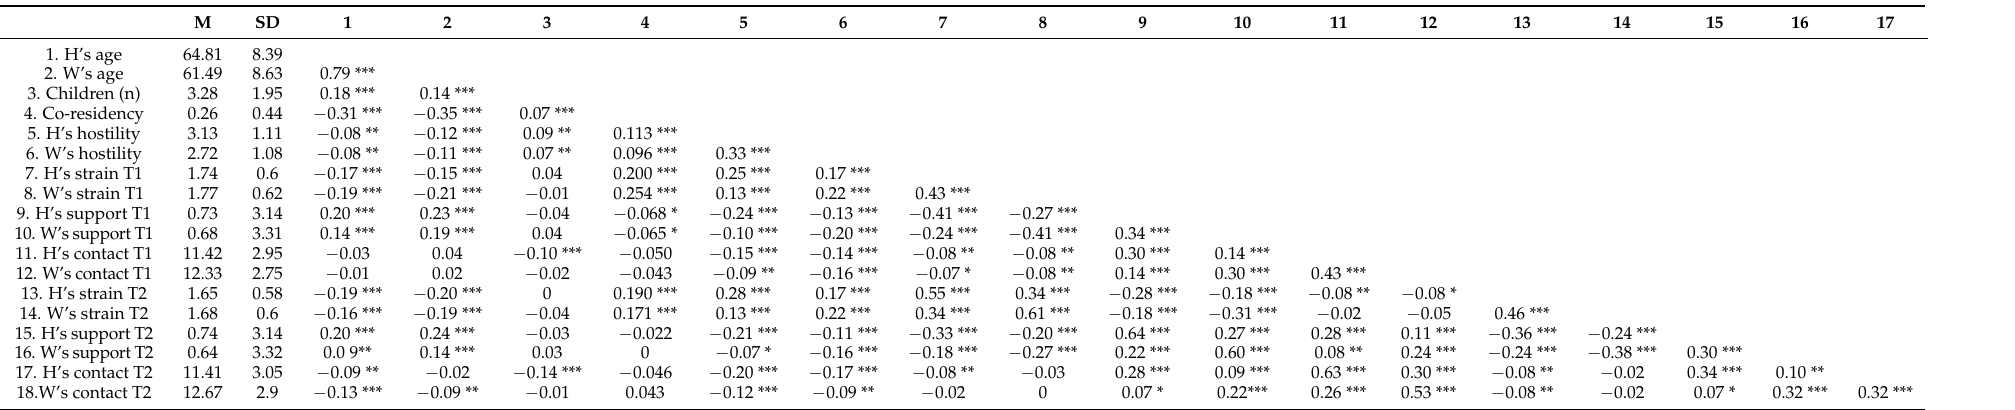
Table 1. Descriptive statistics and correlations between main study